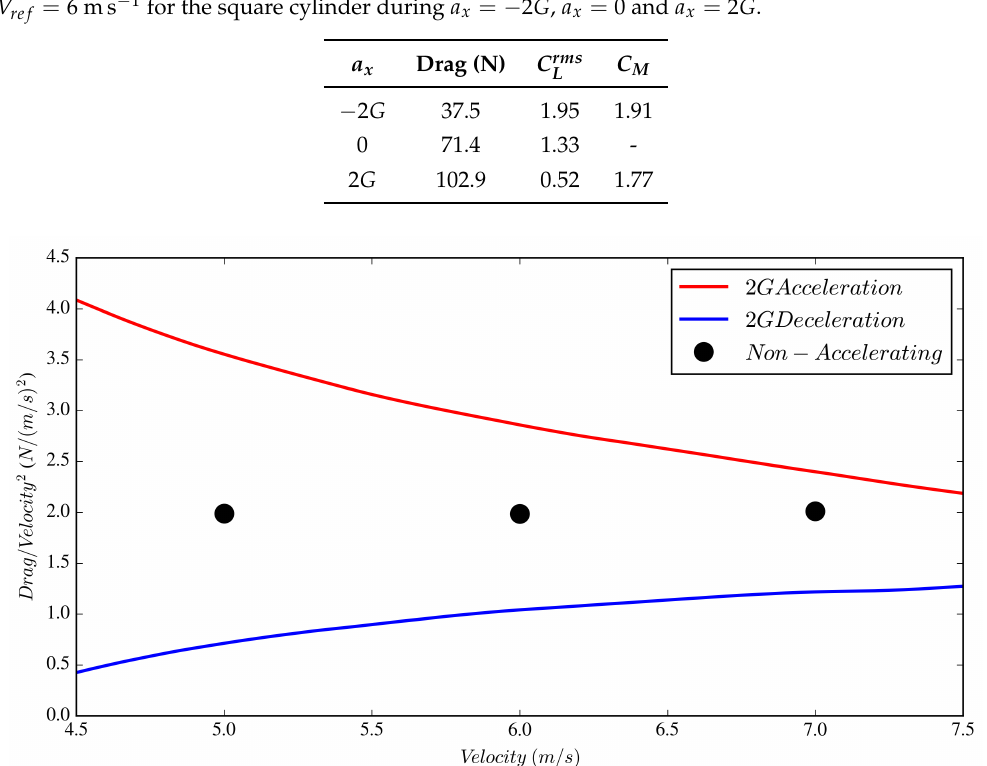
Table 2. Ensemble averaged Drag Force, rms Lift Coefficient, and Morison coefficient C M at